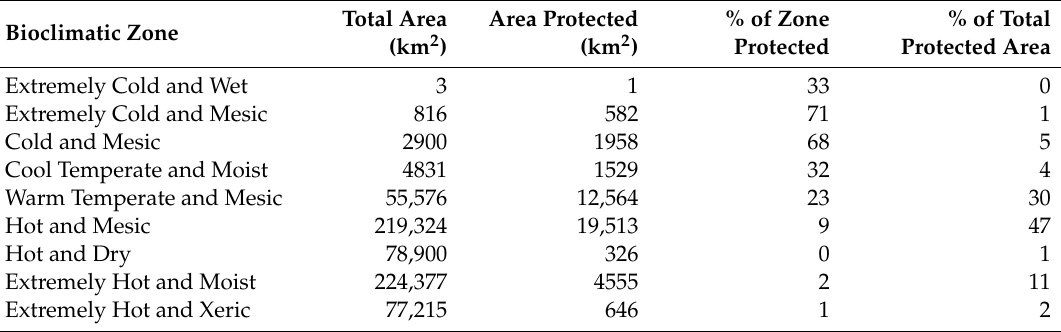
Table 4. Representation of bioclimatic zones within protected areas in